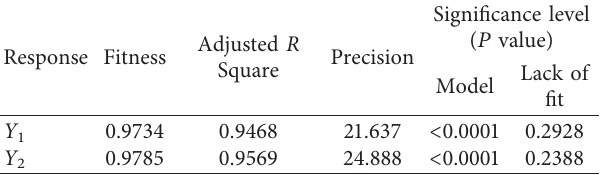
Table 4: Reliability analysis of regression